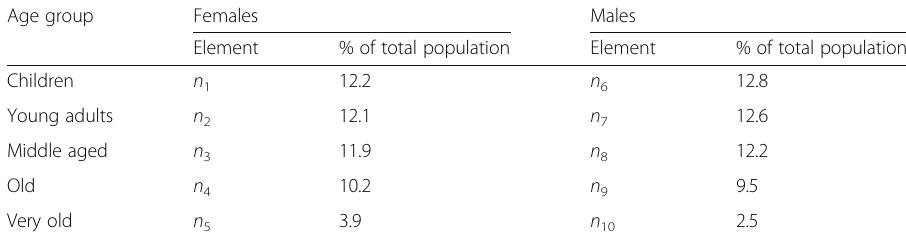
Table 8 The initial stable population vector ( n ): elements as percentages of total Age group Females